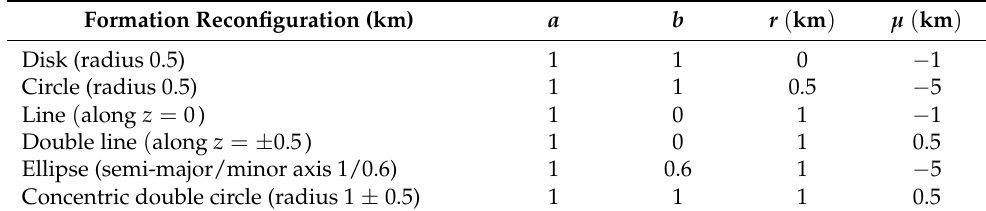
Table 4. Formation reconfiguration control